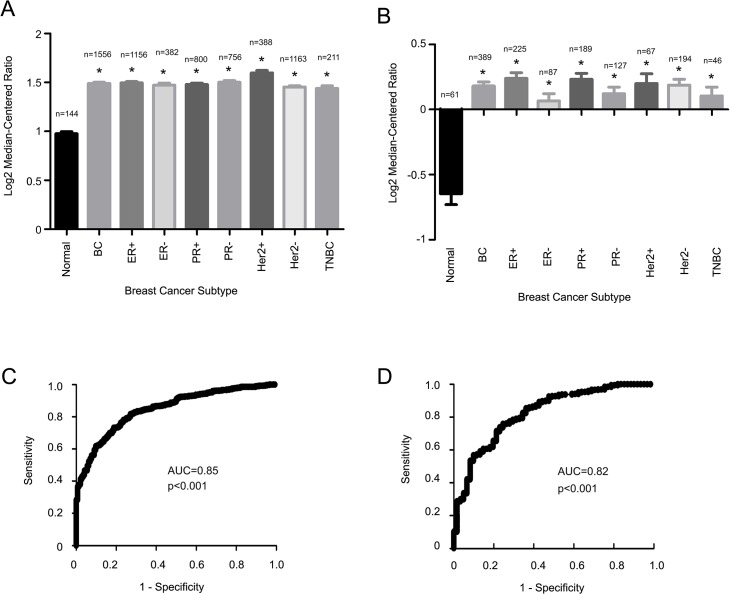
Increases in SIPL1 mRNA in breast cancer.Data from the Curtis (A) and TCGA datasets (B) were extracted from Oncomine and analyzed with respect to SIPL1 mRNA expression in cancer vs. normal tissues. Statistical Analysis was conducted using an unpaired, two-tailed, welch-corrected t-test. Asterisks indicate p<0.0001 in comparison the normal breast tissues. (C), (D) A receiver-operating characteristic (ROC) curve of normal versus primary breast cancer was calculated based the data extracted from the Curtis dataset (C) and the TCGA dataset (D).